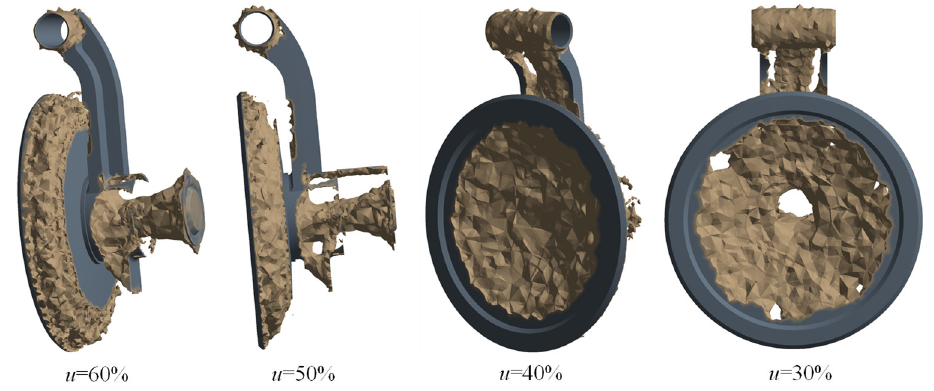
Figure 15. Comparison of material removal areas.